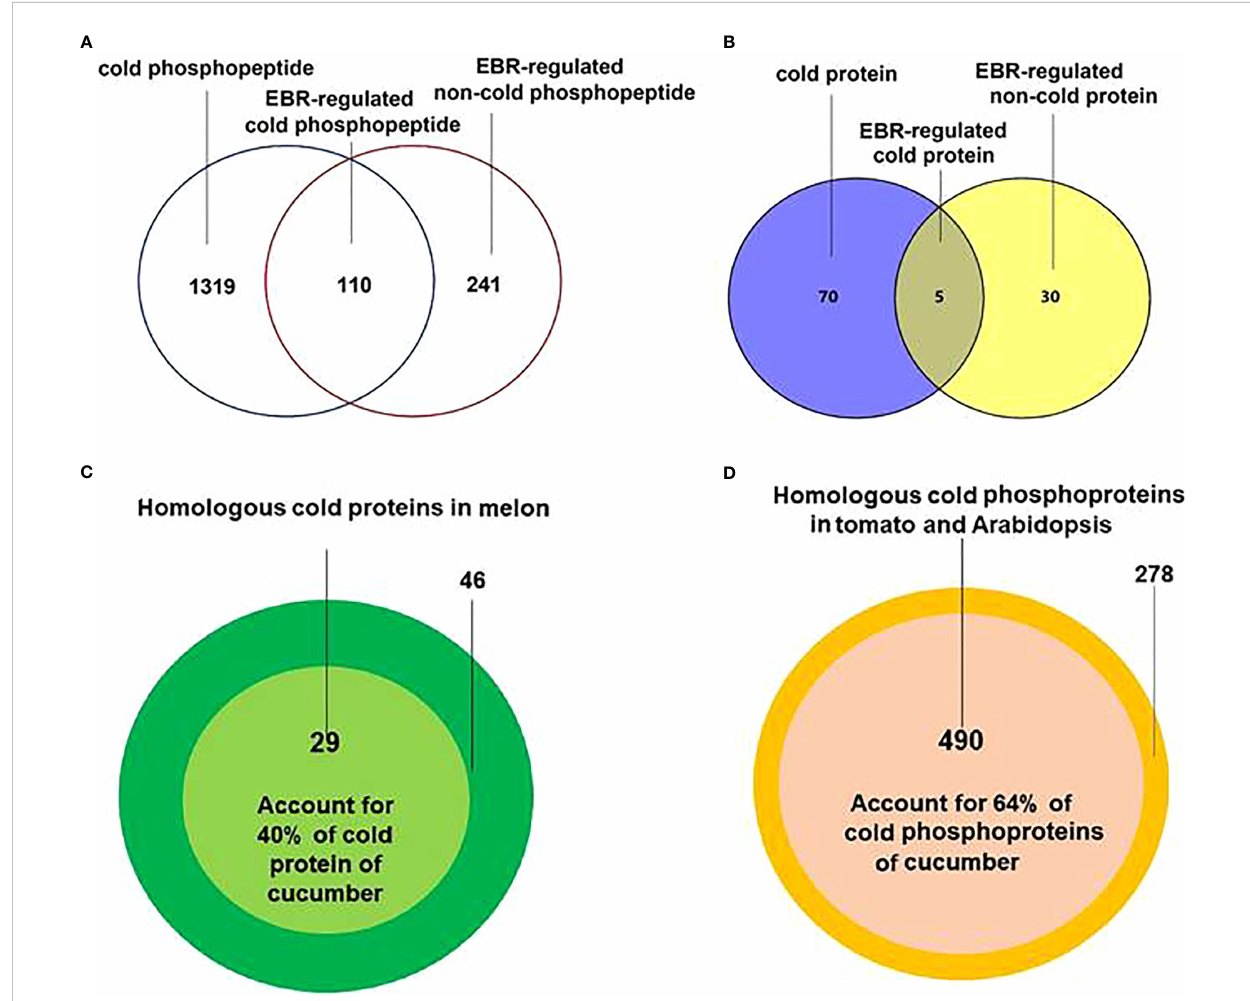
FIGURE 1 Extraction and alignment of differential proteins and differentially expressed phosphoproteins. (A) The Venn of differentially expressed proteins in different treatments. (B) The Venn diagram of differentially expressed phosphoproteins in different treatments. (C) Cold-responsive protein alignment between cucumber and melon. (D) Cold-responsive phosphopeptide corresponding protein alignment between cucumber and Arabidopsis and